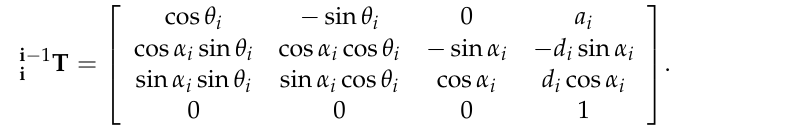
The D–H parameters for error modelling and analysis are listed in Table 1.